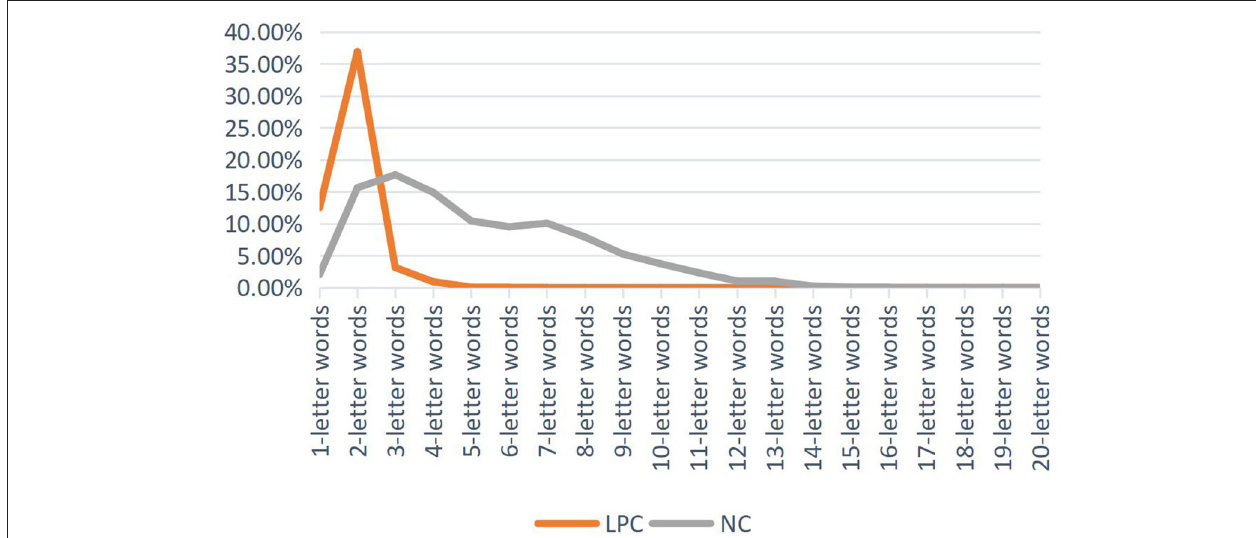
FIGURE 1 | Word length percentage distribution of LPC and